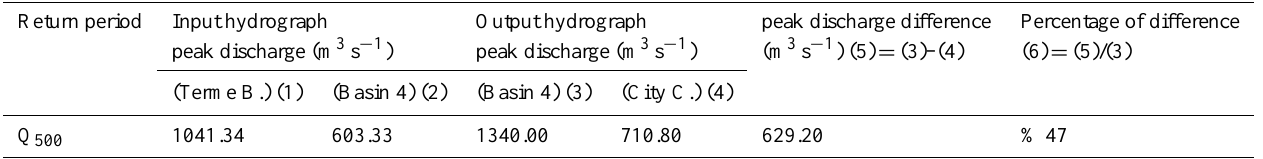
Table 3. Scenario2 model